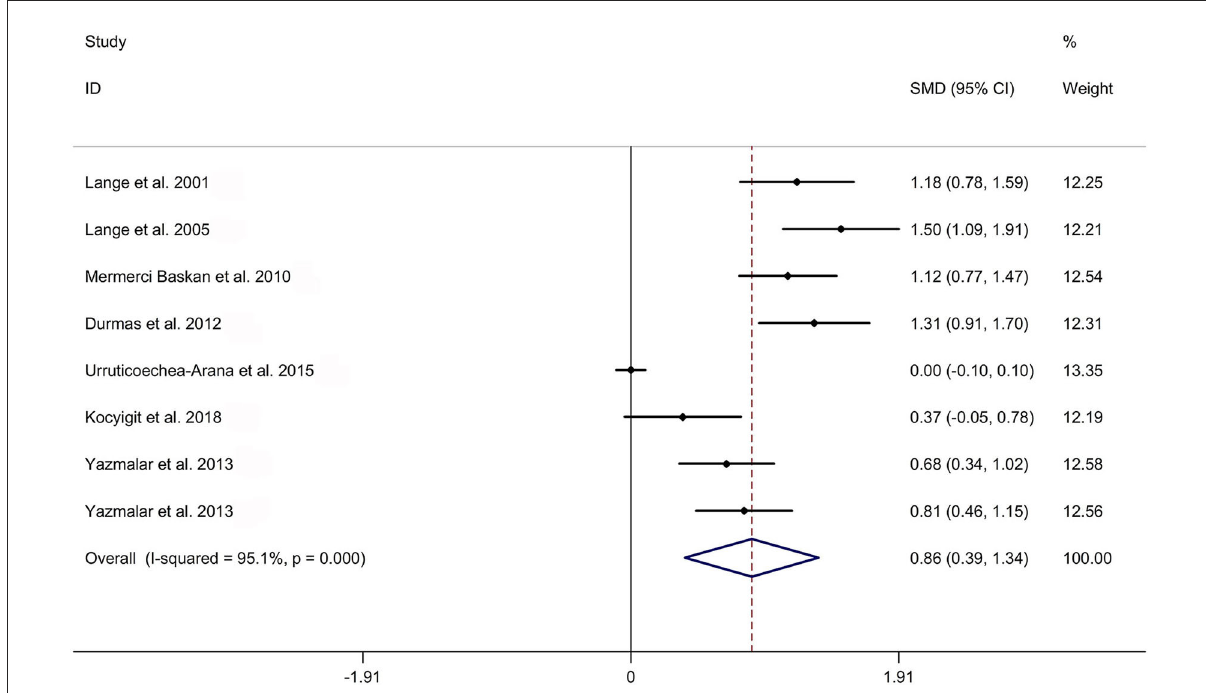
FIGURE5 Forest plot regarding comparison in peripheral ESR levels between AS and HC. AS, ankylosing spondylitis; ESR, erythrocyte sedimentation rate; HC, healthy controls.